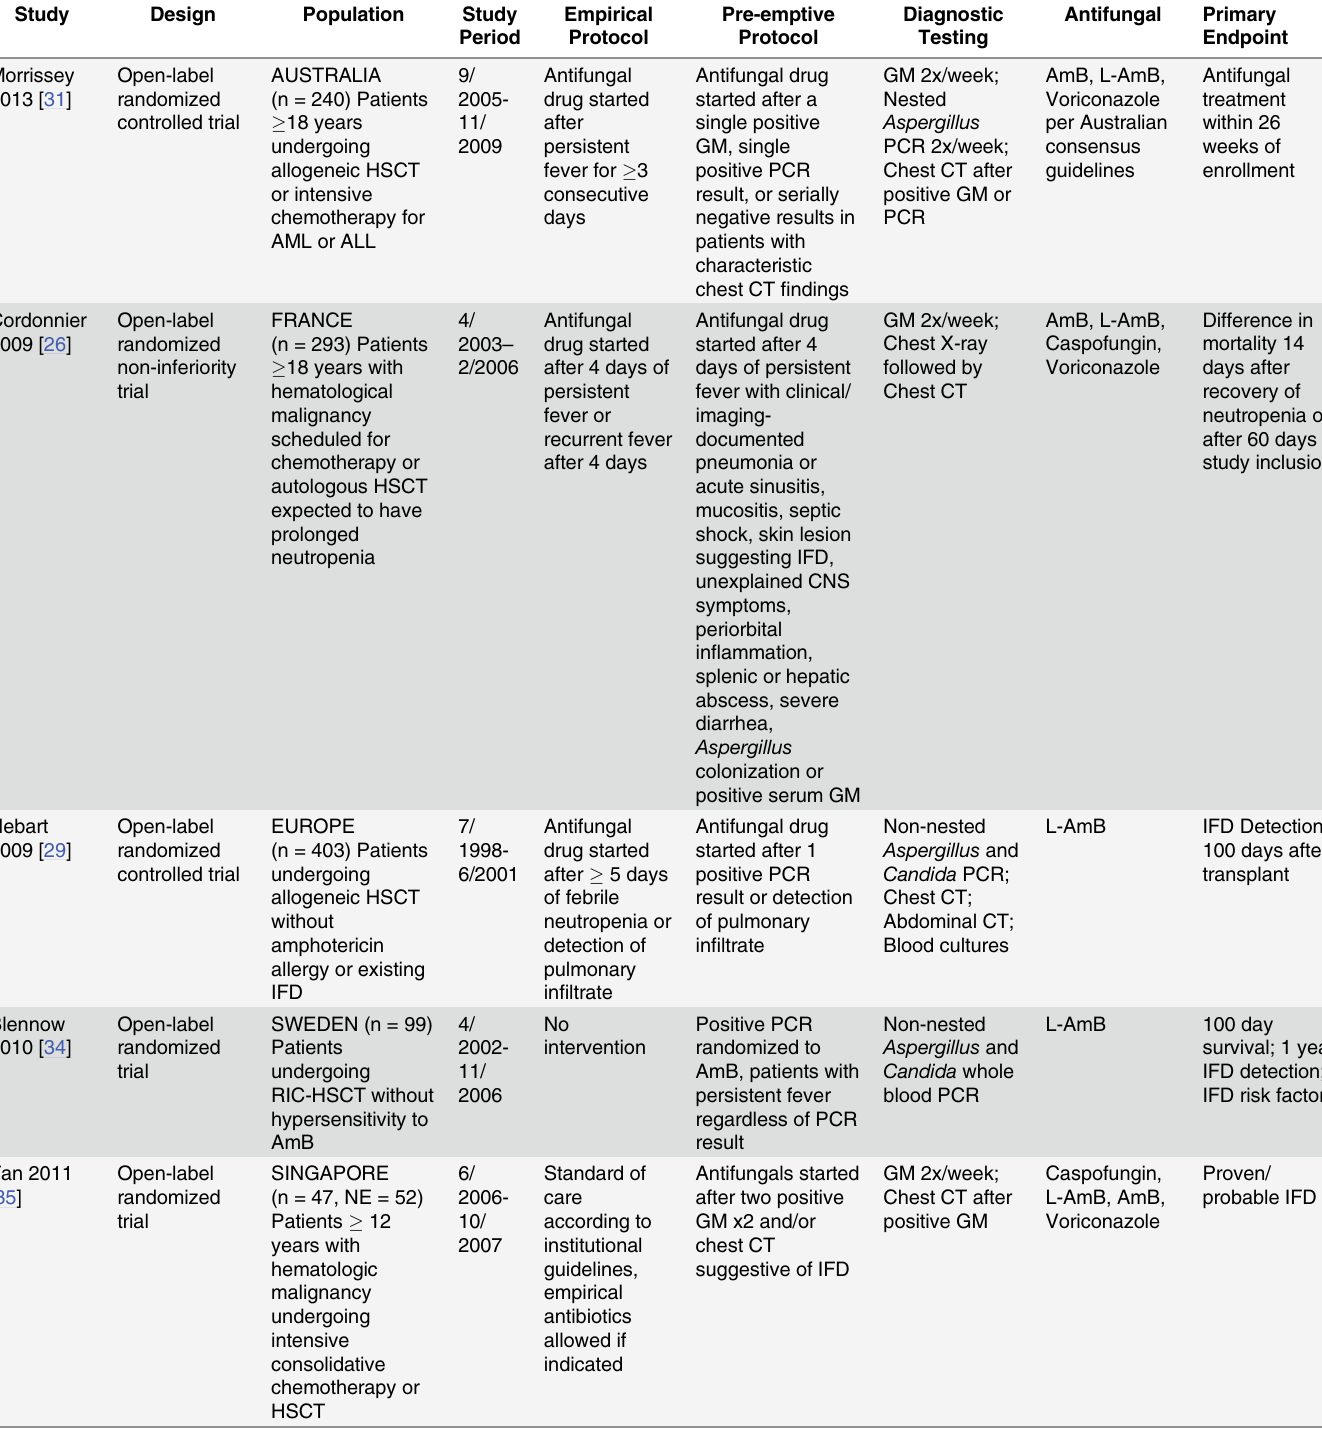
Table 1. Summary of studies comparing empirical versus pre-emptive antifungal therapy in high-risk febrile neutropenic patients.